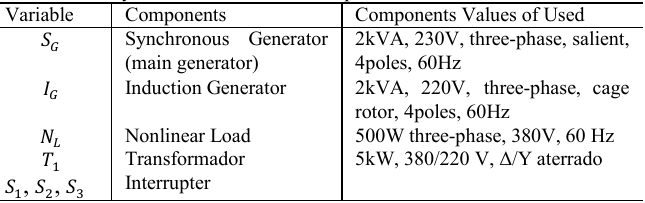
Table I. Acronyms and Values of the Components from IEPS. Variable